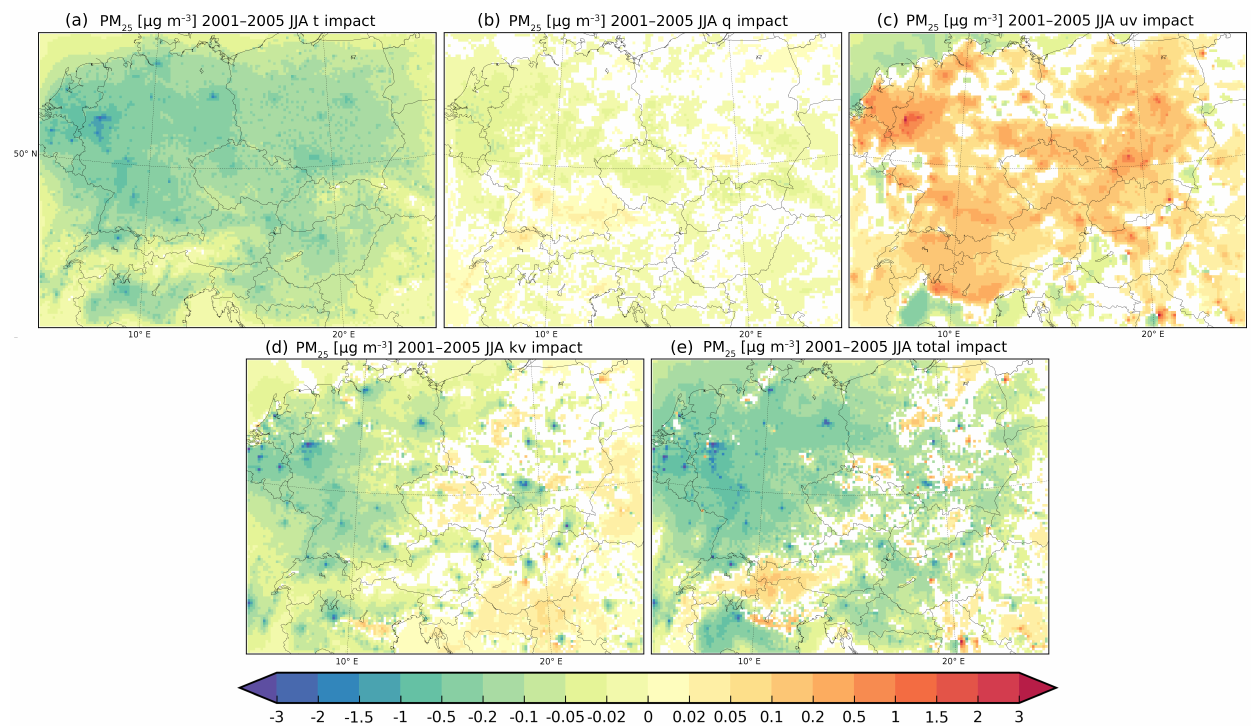
Figure 4. Impact of urban canopy meteorological forcing on PM 2 . 5 surface concentrations in µgm − 3 for the 2001–2005 JJA period for (a) temperature ( t ), (b) humidity ( q ), (c) wind ( uv ), (d) turbulence ( Kv ) and (e) total impact. Shaded areas represent a statistically significant impact at the 98% level using the t